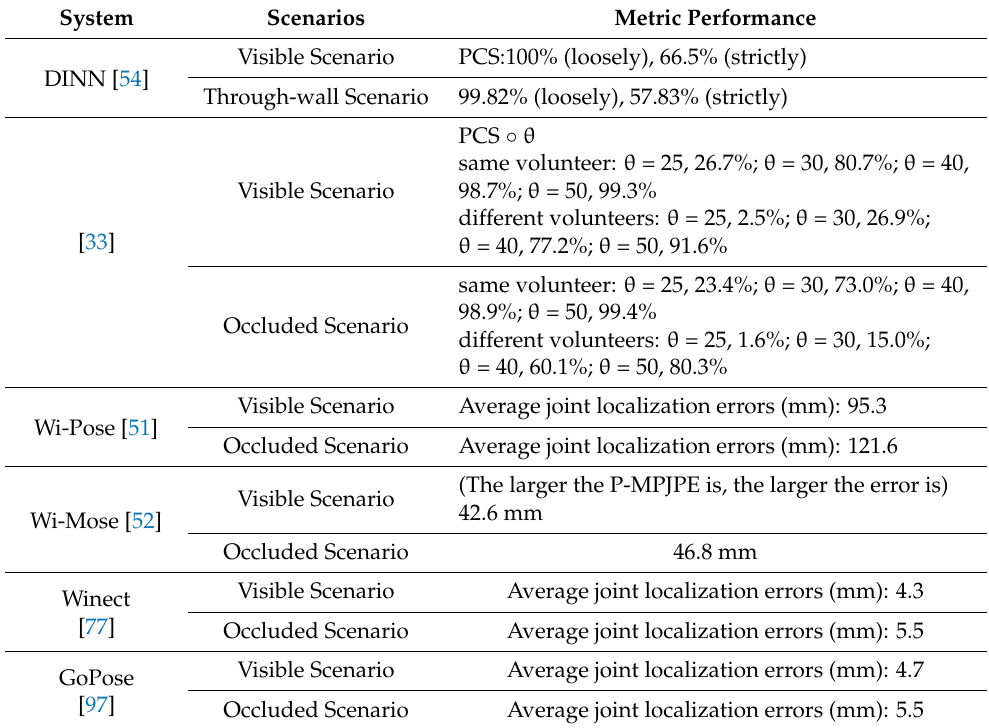
Table 7. Identification Results of LoS and